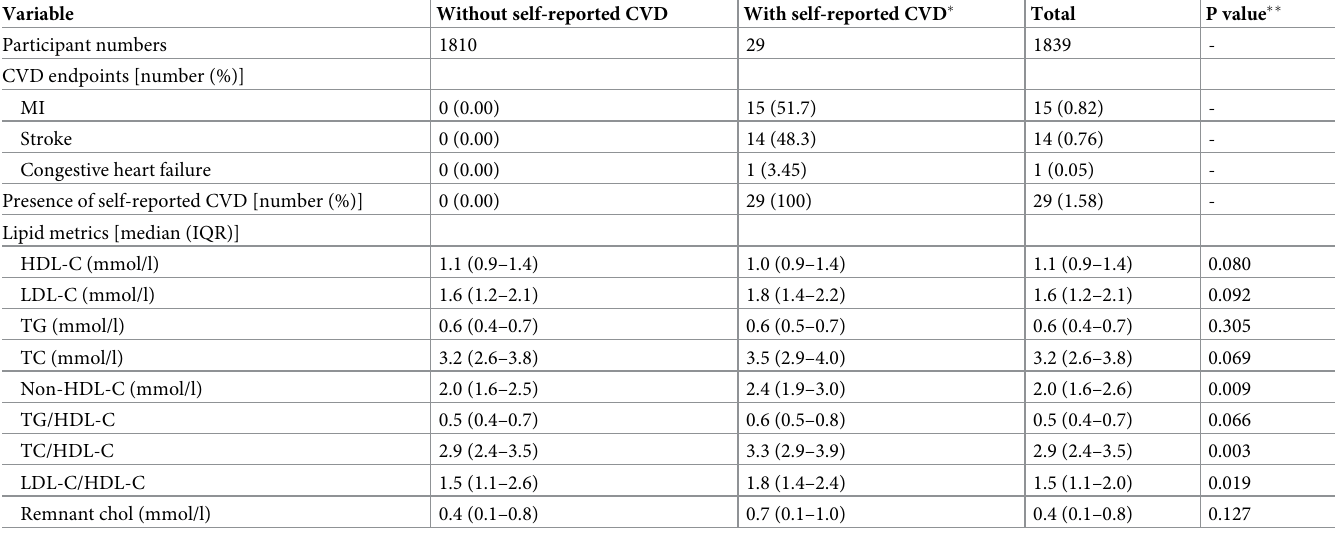
Table 2. Self-reported CVD endpoints and median levels of lipid metrics according to self-reported CVD